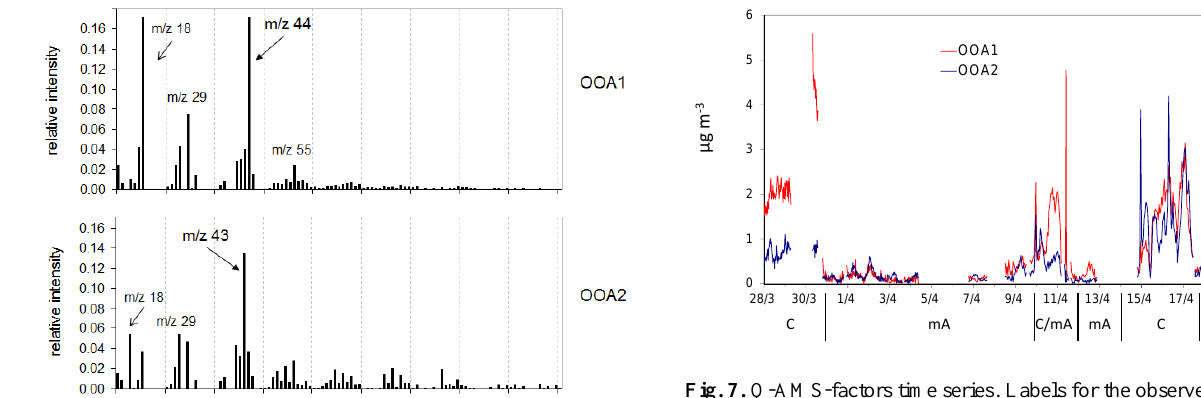
Fig. 7. Q-AMS-factors time series. Labels for the observed distinct BTs regimes are reported under the time